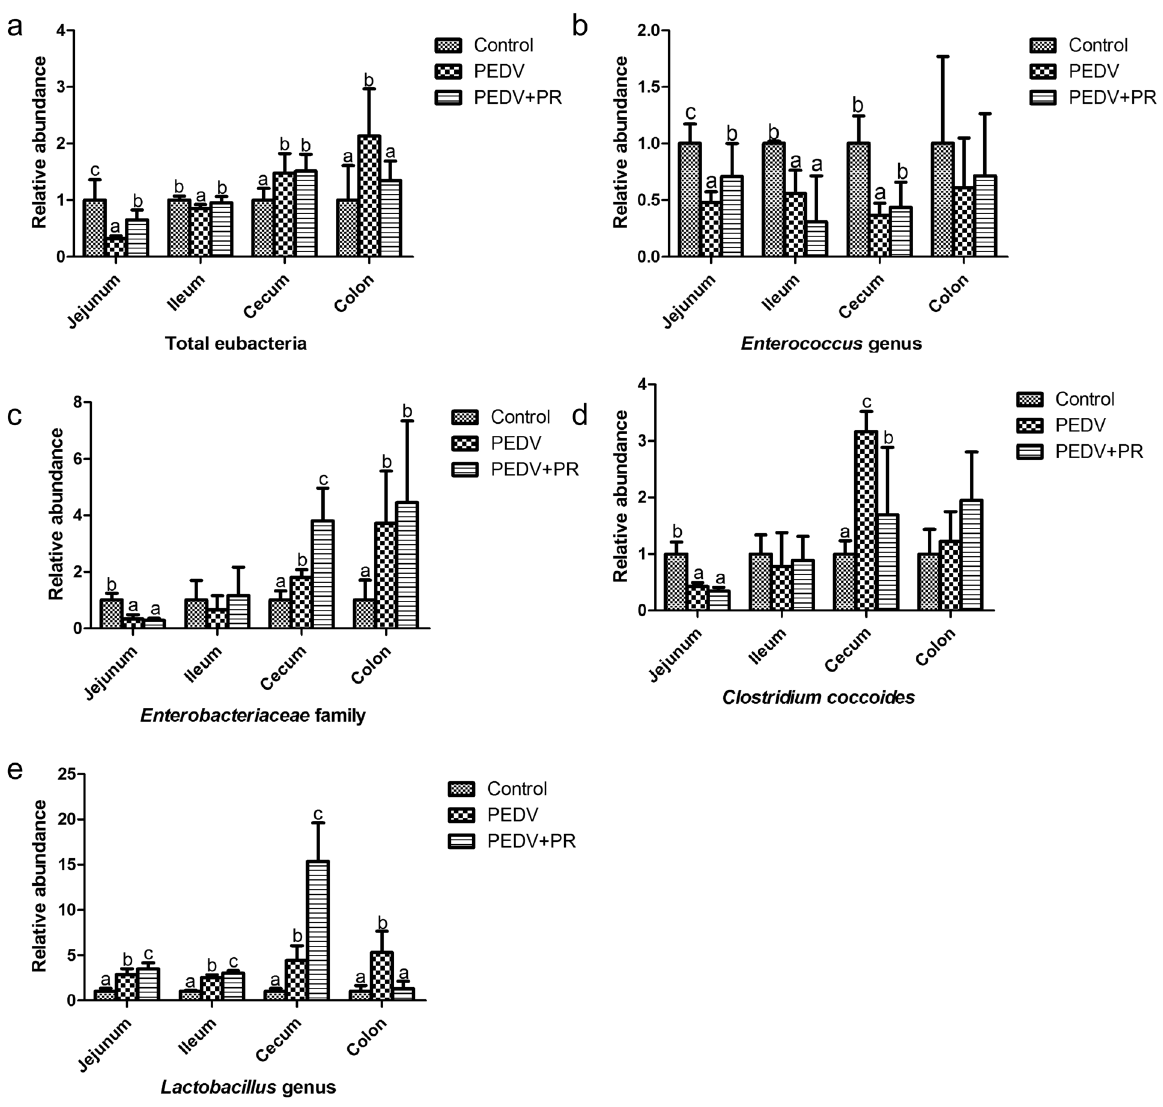
Figure 6. Effects of puerarin (PR) administration on selected bacteria of piglets after PEDV infection, ( a ) Total eubacteria (16S rRNA) , ( b ) Enterococcus genus, ( c ) Enterobacteriaceae family, ( d ) Clostridium coccoides , ( e ) Lactobacillus genus Values are mean and SD, n = 8. a, b, c , Values within a column not sharing a common superscript letter indicate significant difference at P <